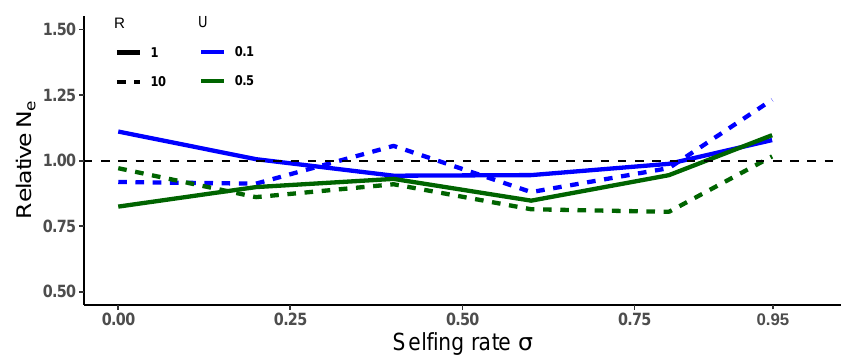
Figure S6 – Effective population size, N e , in a populations supporting a POD zone rela- tive to a population without one (done by setting s = h = 0 ). N e varies as a function of the selfing rate for populations subject to different background mutation rates ( U ) and shorter and longer map lengths ( R in Morgans). These simulations use 100 POD load loci 6 ( n L = 100 ) and a map length of ℓ = 10 − Morgans. Mutations within the POD zone are randomly placed. Selection coefficients in- and outside the POD zone ( s and s d respec- tively) are 0.01 with dominances h and h d = 0.2